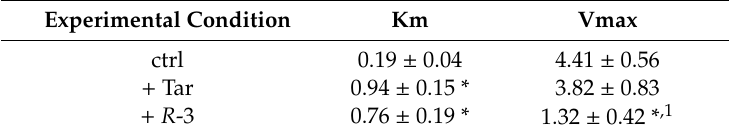
Table 1. Kinetic parameters of doxorubicin efflux in MDA-MB-231/DX cells. Experimental Condition